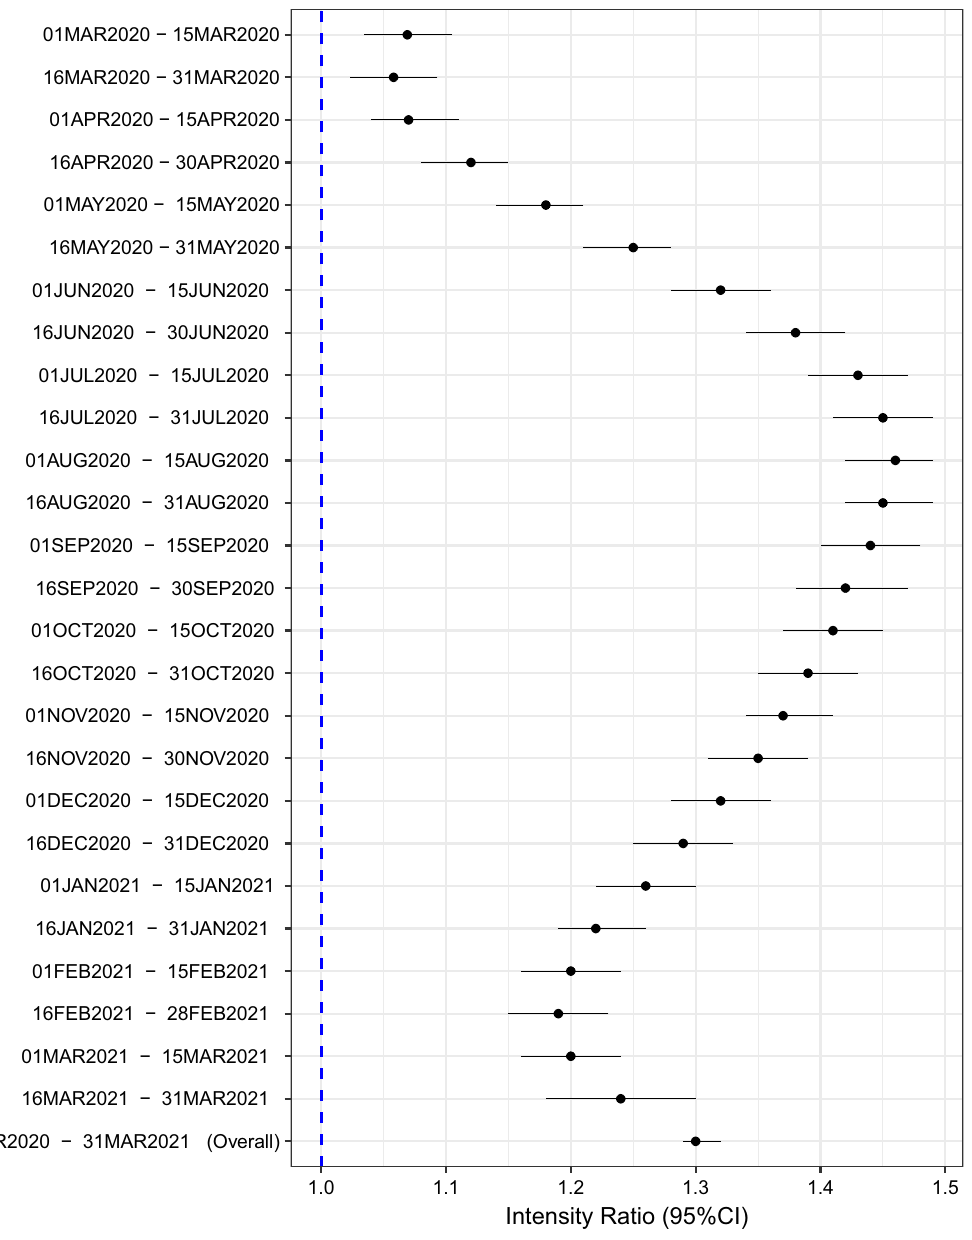
Figure 1. Bimonthly intervals for intensity of GV during and before the pandemic . Bimonthly interval- specific intensity ratio (IR) and their 95% confidence intervals of GV. The dashed blue line in the forest plot represents the null estimate. IR greater than one indicates higher intensity of GV during COVID-19 pandemic compared to